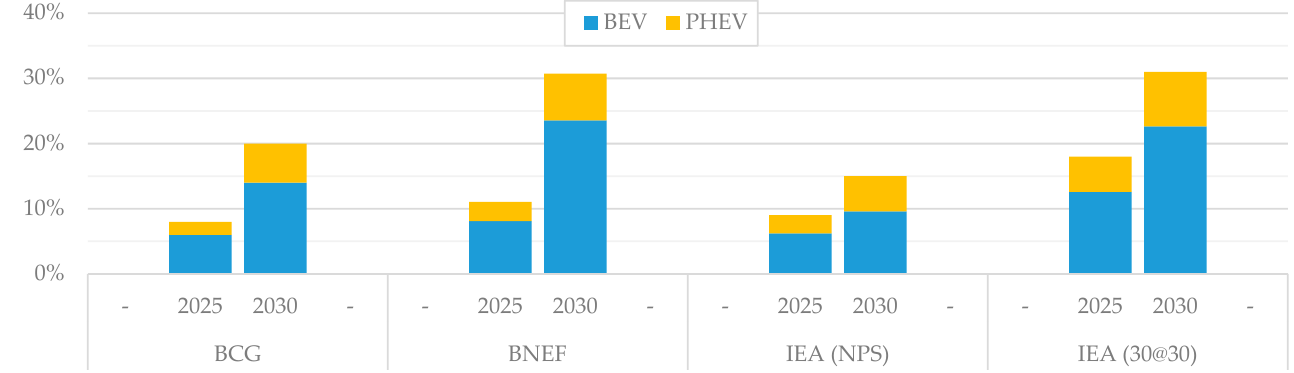
Figure 2. Estimated average BEV and PHEV penetration index on car sales, for 2025 and 2030, at world level, based on different forecasting